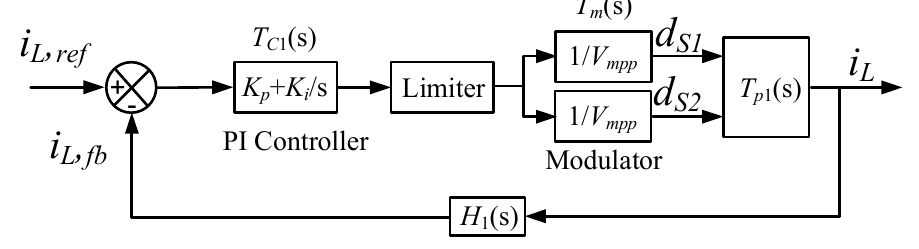
Figure 7. Inner current control loop schematic diagram.